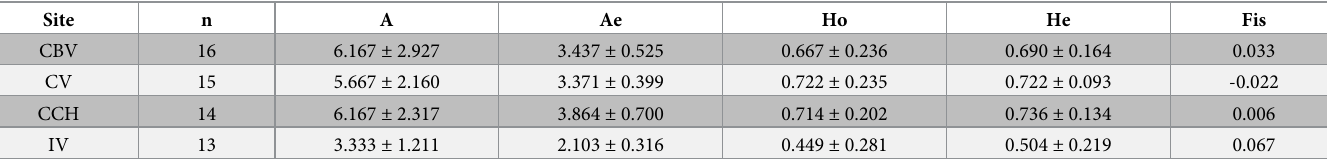
Table 4. Mean ( ± sd) genetic diversity estimates for six microsatellite loci from the timberline wren in four populations in Costa Rica.